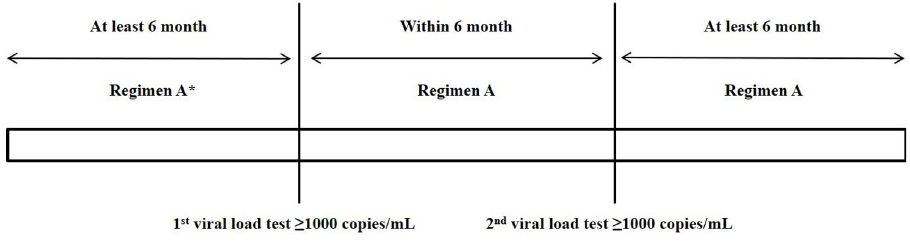
Fig 1. Schematic representation of definition of holding regimen. � Regimen A refers to holding regimen.